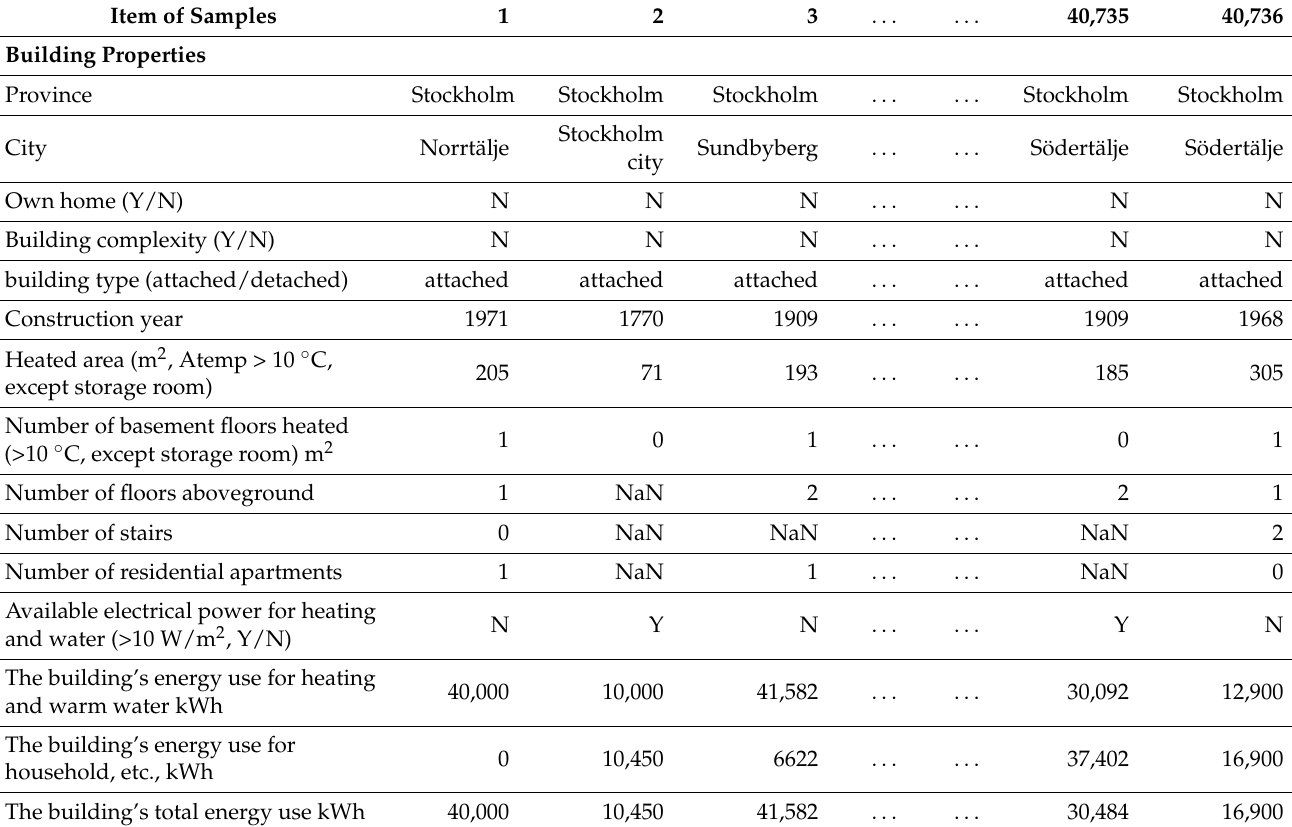
Table A2. The EPC records of Stockholm for city-scale method